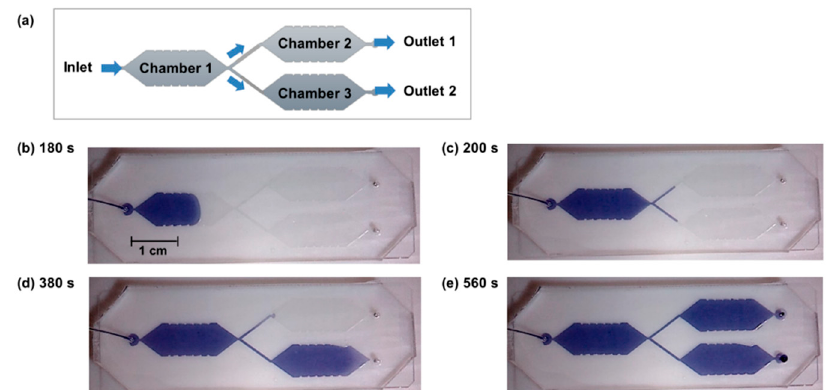
Figure 4. Investigation of the filling of a microfluidic device with three separated reaction chambers and a Y-junction without microvalves. The design is schematically shown in ( a ). An aqueous solution of blue ink is used for visualization and pumped at a flow rate of 5 µL/min. The pictures ( b – e ) are taken at different times and visualize that no parallel flushing of the rear chambers occurs.